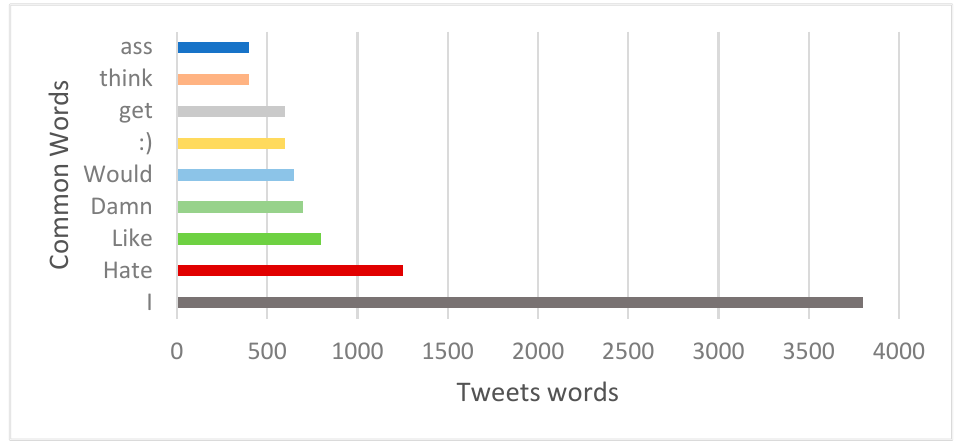
Figure 7. Common Words.